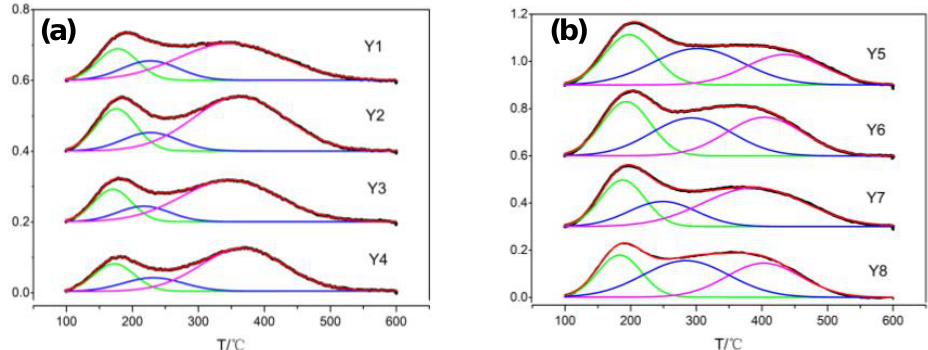
Figure 2. ( a ) NH 3 -TPD profiles of Y1–Y4 and ( b ) NH 3 -TPD profiles of Y5–Y8. Black line: the desorption peak of zeolite acid sites obtained by testing. Green line: the desorption peak of weak acid sites obtained by fitting. Blue line: the desorption peak of medium acid sites obtained by fitting. Pink line: the desorption peak of strong acid sites obtained by fitting. Red line: the desorption peak of zeolite acid sites obtained by fitting.